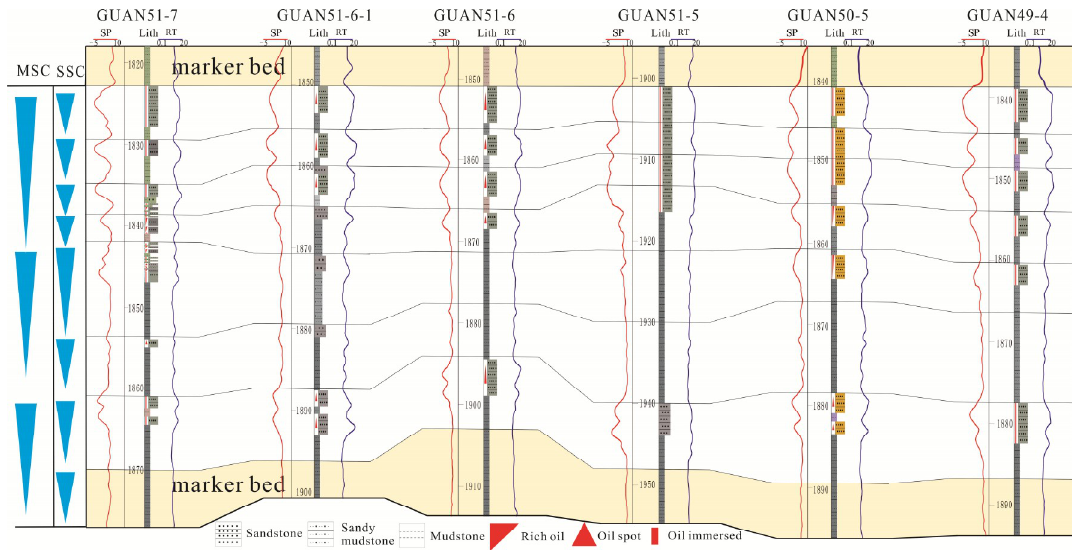
Figure 4. Cycle identification and stratigraphic correlation. SP, spontaneous potential curve; RT, resistivity curve.